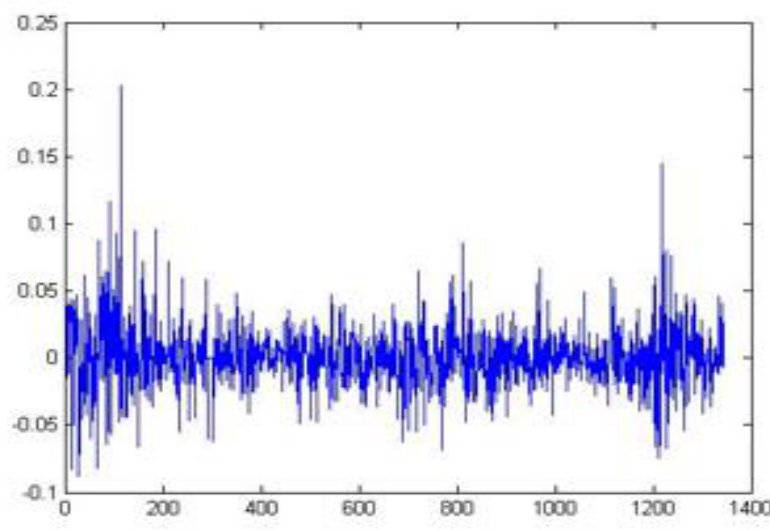
Fig. 1. Time series plot for the Axis Bank stock from Feb’09-Feb